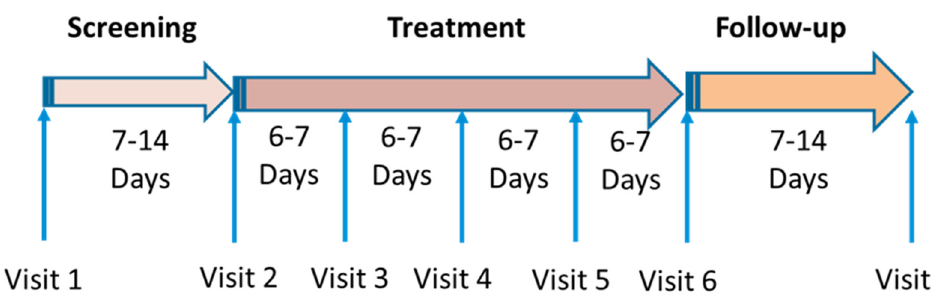
Figure 2. Study phases and visits to the clinic.